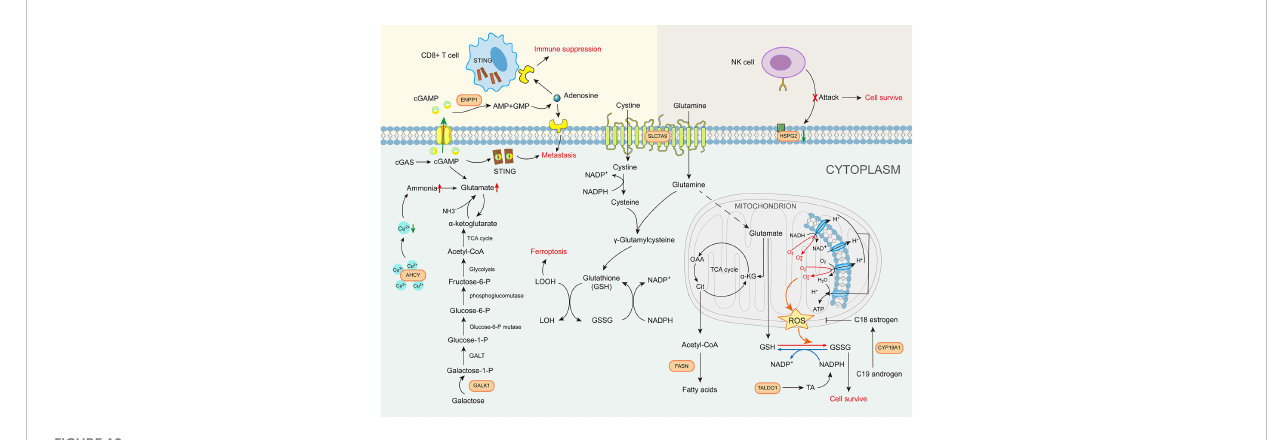
FIGURE 10 The role of glutamine metabolism immunity index gene in glutamine metabolism-related